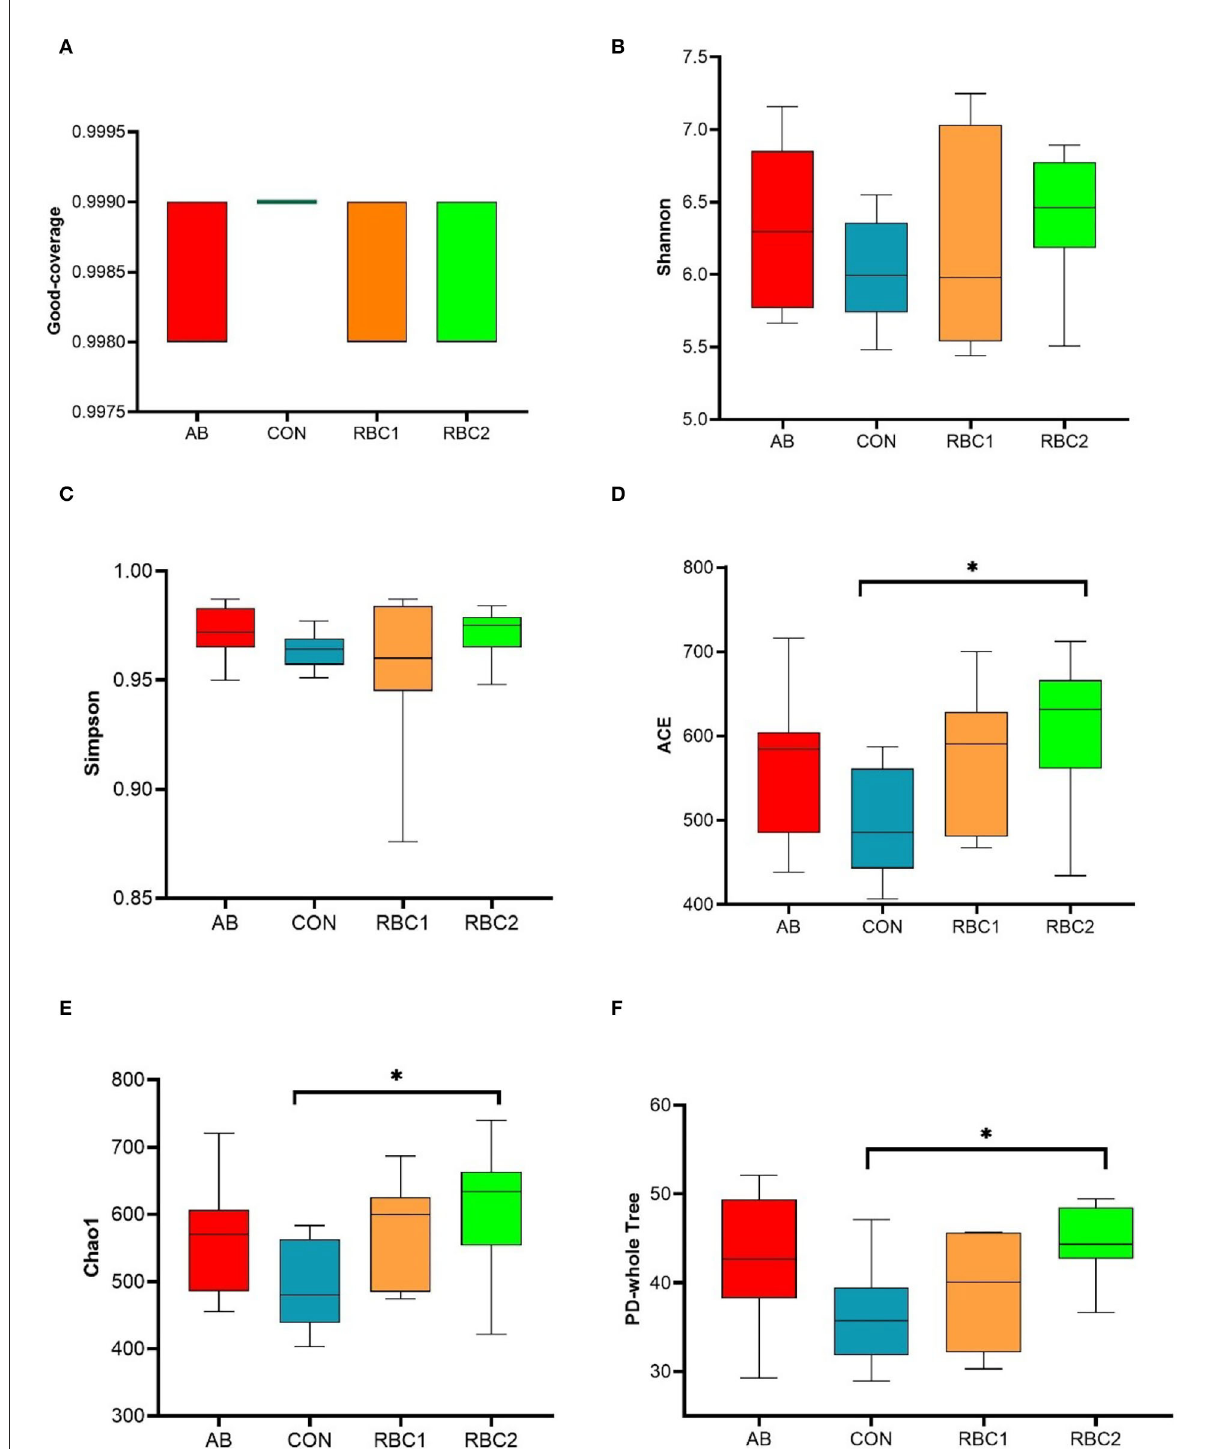
FIGURE1 Effect of dietary RBC and antibiotics (AB) supplementation on the α and β diversity in the colonic digesta of weaning piglets. (A–F) Goods-coverage, Shannon, Simpson, ACE, Chao1, and Ph-whole tree indices of α diversity. n = 7 for each treatment. CON, basal diet; AB, basal diet + 25 mg/kg bacitracin zinc + 5 mg/kg colistin sulfate; RBC1, 5 g/kg reduction in soybean meal of basal diet + 5 g/kg RBC; RBC2, 10 g/kg reduction in soybean meal of basal diet + 10 g/kg RBC. *Means P <